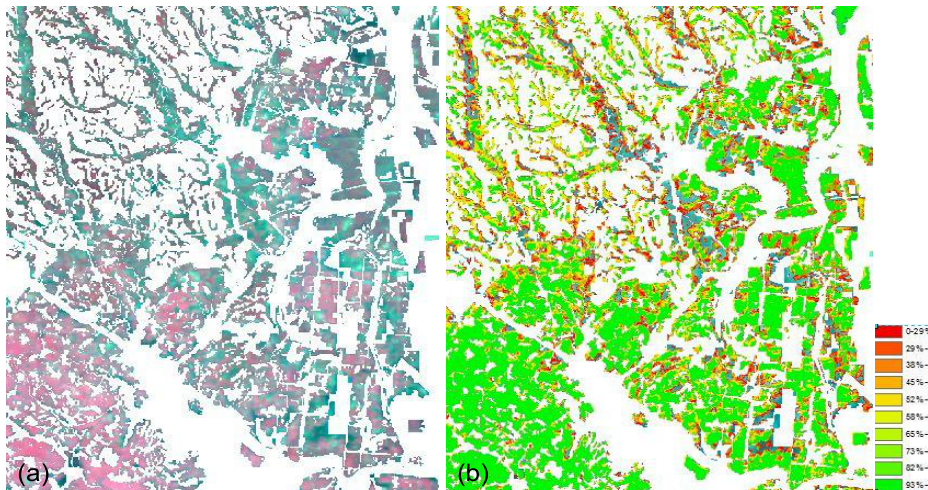
Figure 3. One example of decomposition of mixed pixels in Dingcheng District (a. HJ CCD images; b. the fraction of late-season rice)